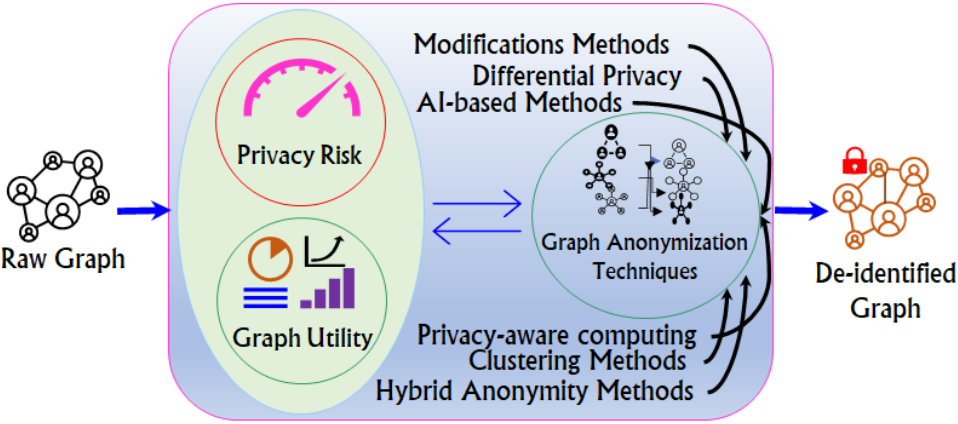
Figure 9. Overview of the anonymization process applied to G for